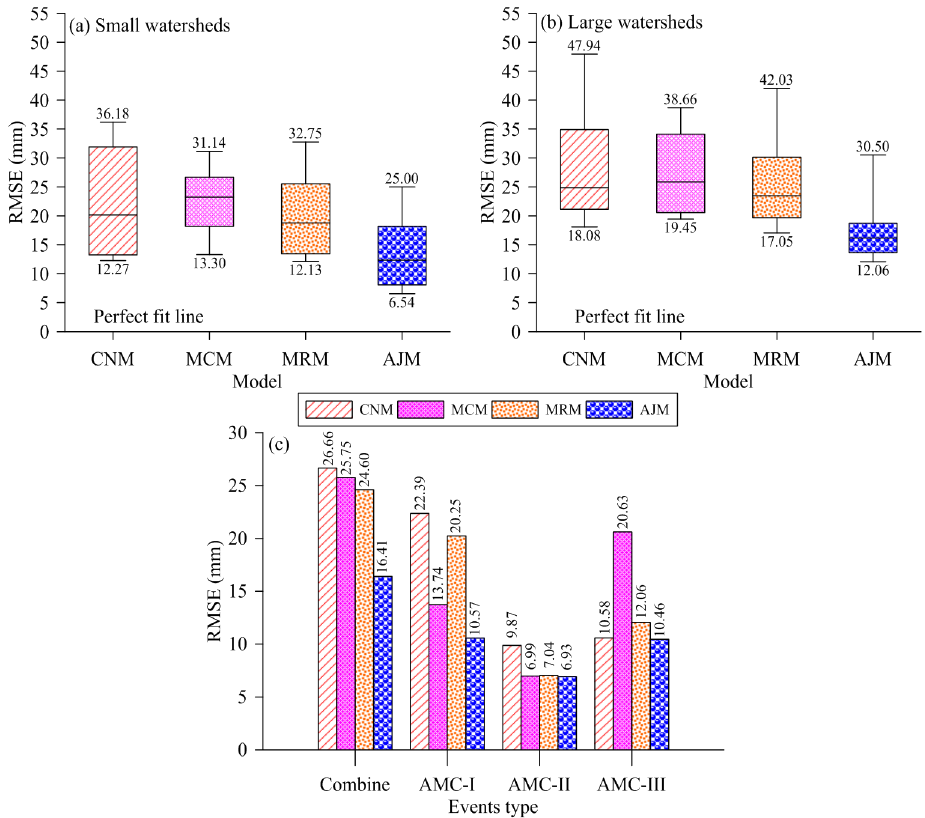
Figure 3. Model performance based on root mean squares error (RMSE) ( a ) in small watersheds (Area < 250 km 2 ); ( b ) in larger watersheds (Area > 250 km 2 ) and ( c ) for different types of events (dry, normal, and wet).